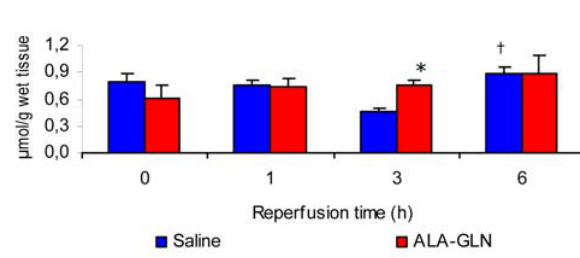
FIGURE 6 - Kidney glucose concentrations in saline and L-alanyl-glutamine treated rats.